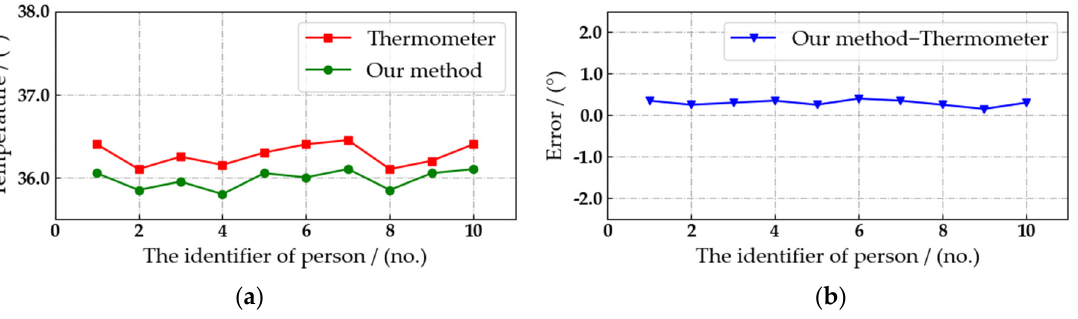
Figure 19. Comparison of pedestrian body temperature detection results at a distance of 5 m. ( a ) Temperature detection results. ( b ) Detection error.